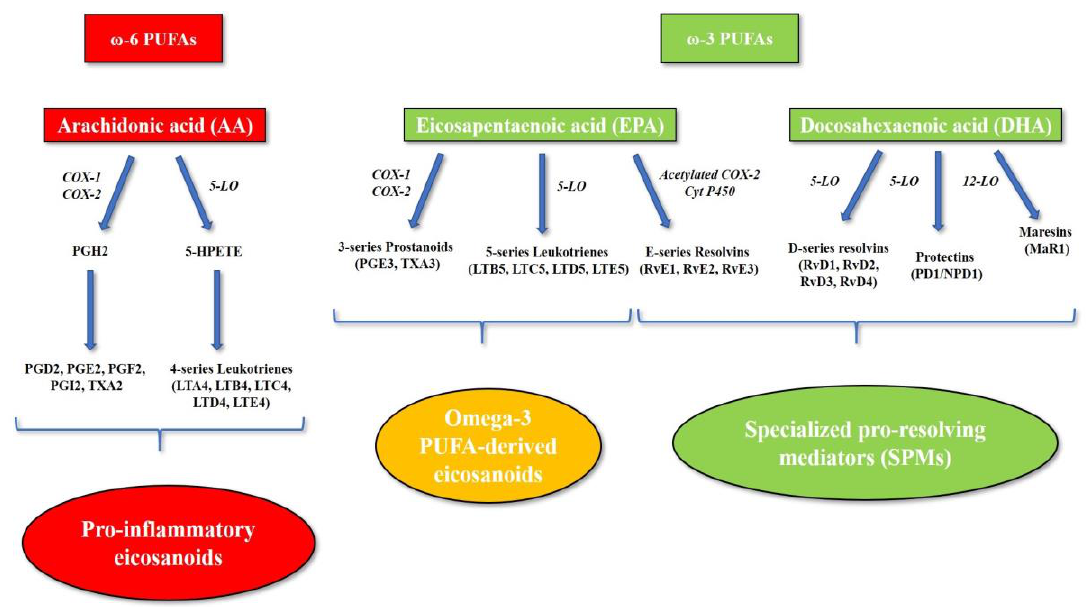
Figure 2. Eicosanoid and specialized pro-resolving mediator biosynthesis. The omega-6 PUFA arachidonic acid is the precursor of the pro-inflammatory eicosanoids. Cyclooxygenase and lipoxygenase enzymes catalyze the conversion of arachidonic acid into a series of pro-inflammatory mediators, including prostaglandins, thromboxanes and pro-inflammatory leukotrienes (4-series leukotrienes). The omega-3 PUFA eicosapentaenoic acid is also a substrate for arachidonic acid-cascade enzymes (cyclooxygenase and 5-lipoxygenase), leading to the production of alternative omega-3 PUFA-derived eicosanoids, such as 3-series prostanoids and 5-series leukotrienes, which are inactive metabolites or display lower pro-inflammatory activity compared to arachidonic acid-derived eicosanoids. Moreover, omega-3 PUFAs represent the precursors of a series of lipid mediators, including resolvins, protectins and maresins, which are collectively termed “specialized pro-resolving mediators” (SPMs). Abbreviations: 5-HPETE, 5-hydroperoxyeicosatetraenoic acid; 5-LO, 5-lipoxygenase; AA, arachidonic acid; COX-1, cyclooxygenase-1; COX-2, cyclooxygenase-2; Cyt